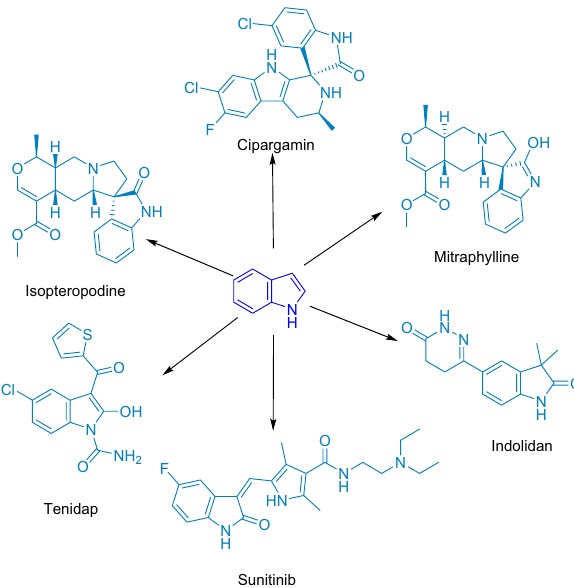
Figure 1. Some biologically active oxindoles and